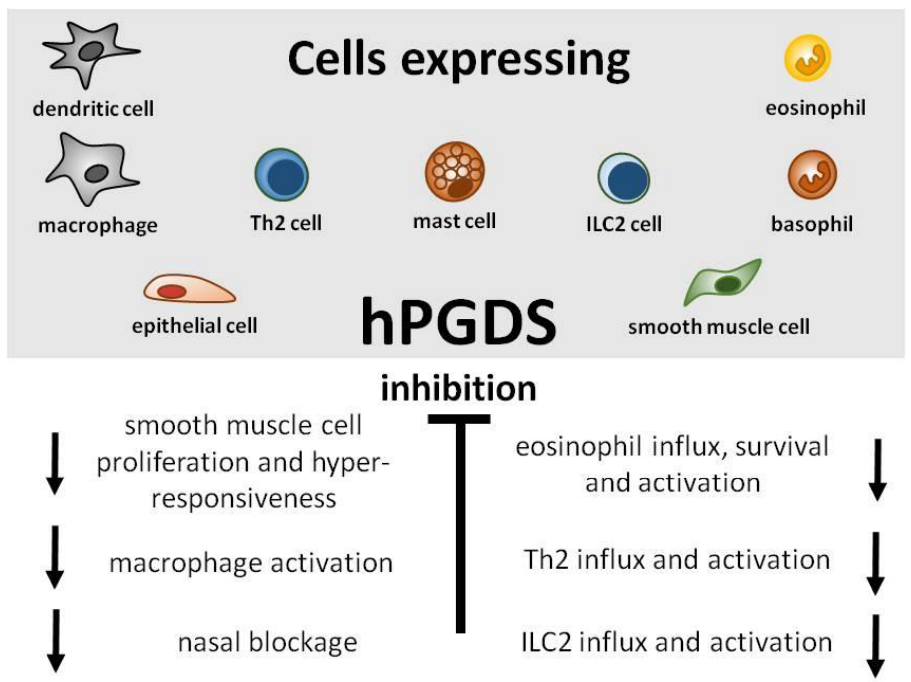
Figure 2. Potential target cells and beneficial e ff ects of hPGDS inhibition in allergic inflammation. Hematopoietic PGDS expression has been reported in many cell types involved in allergic inflammation. ElevatedPGD 2 levelshavebeenshowntoinduceDP2 / CRTH2-mediatedsmoothmusclecellproliferation and hyperresponsiveness [103], macrophage activation [11], nasal blockage [10] as well as influx, activation and survival of eosinophils, ILC2s and Th2 cells. Inhibition of hPGDS-derived PGD 2 production would target all above-mentioned pathological phenomena. Cells 2019 , 8 , x FOR PEER REVIEW